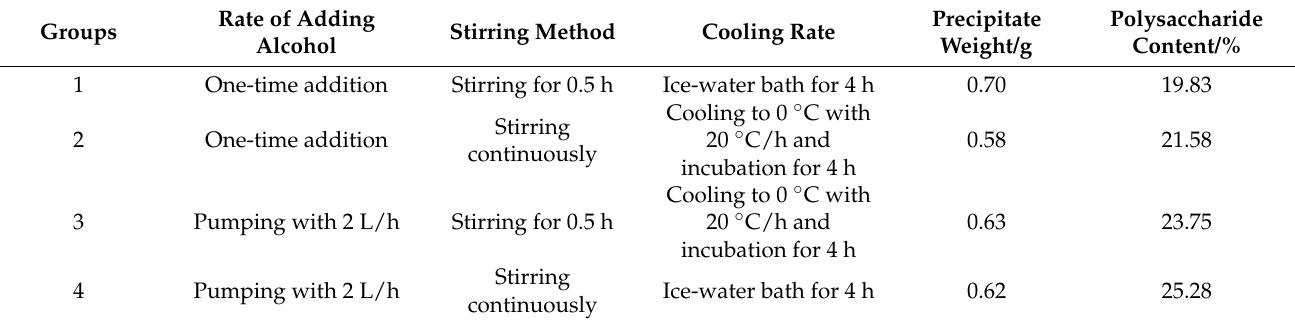
Table 3. Effects of different alcohol precipitation